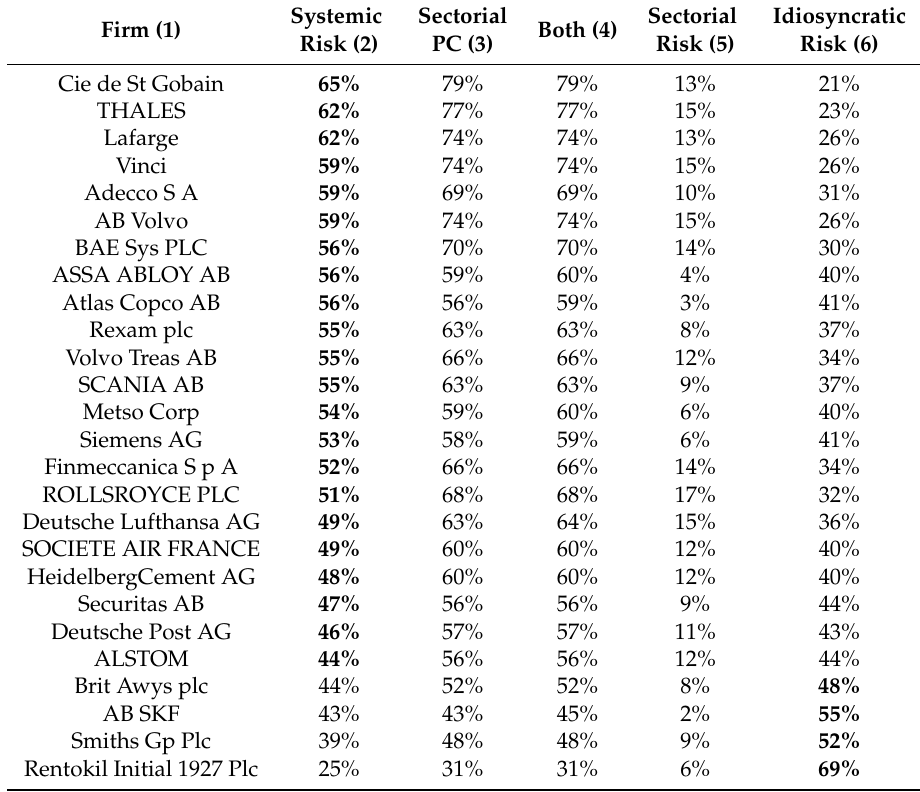
Table 11. Credit risk decomposition for the European industrial